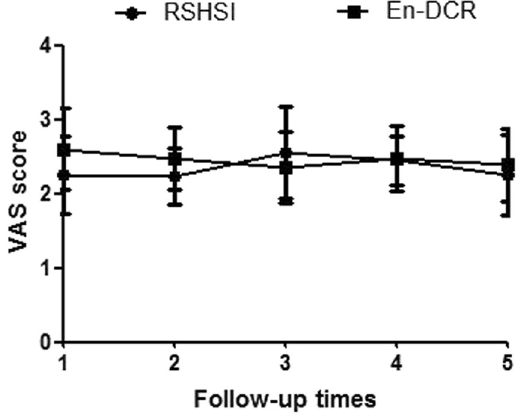
Figure 9. Postoperative epiphora improvement five times in one year follow-up including 6 months tube placement and 6 months after extubation. (n = operative eyes, P > 0.050).